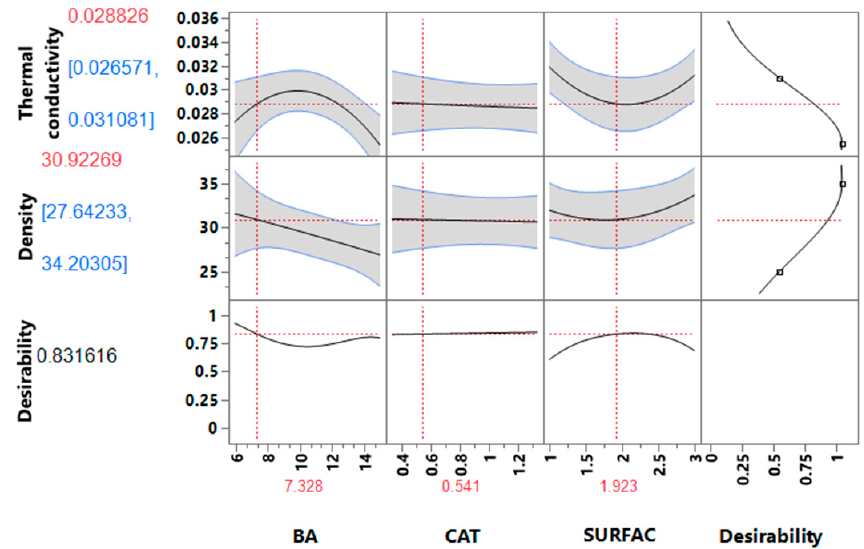
Figure 1. Prediction profiler for thermal conductivity and density of RPUFs.